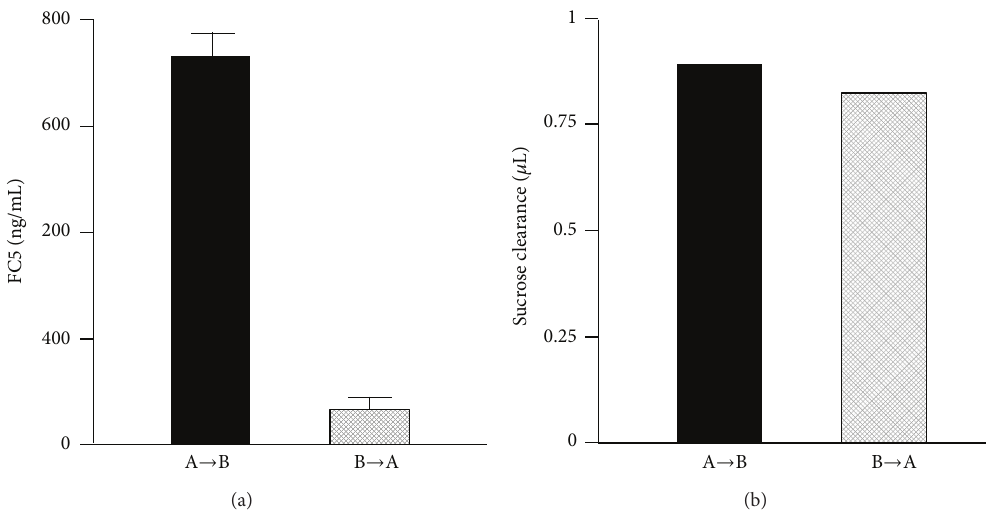
Figure 3: (a) Polarized transmigration of FC5 across HCEC monolayers. Transport studies were initiated by adding 10 𝜇 g/mL FC5 to either apical (A to B) or basolateral (B to A) compartment and the amount of FC5 in the opposite compartment was determined after 30 min. (b) [14 C ] Sucrose distribution across the same HCEC monolayers was used as internal control for paracellular transport (adapted and modified from Figure 1,